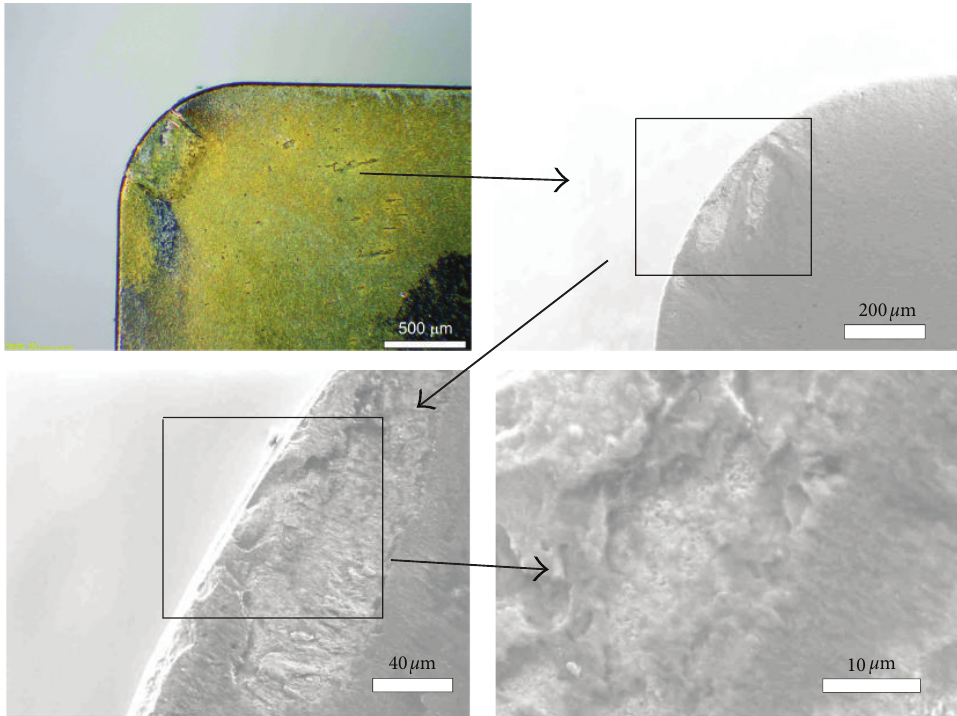
Figure 7: SEM examination of worn rake face of TiN-coated cutting tool: 𝑣 𝑐 = 150 m/min, 𝑓 = 0.20 mm/rev, and 𝑎 𝑝 = 0.1 mm.